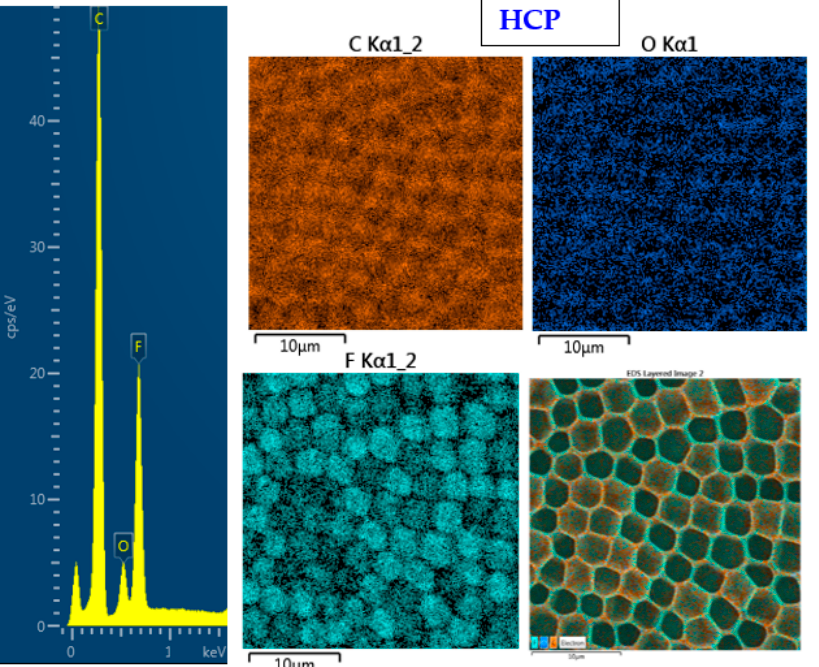
Figure 3. EDS spectrum and elemental maps with layered EDS images for the honeycomb-like (HCP) structure on the plasma-treated fluorinated ethylene propylene (FEP).